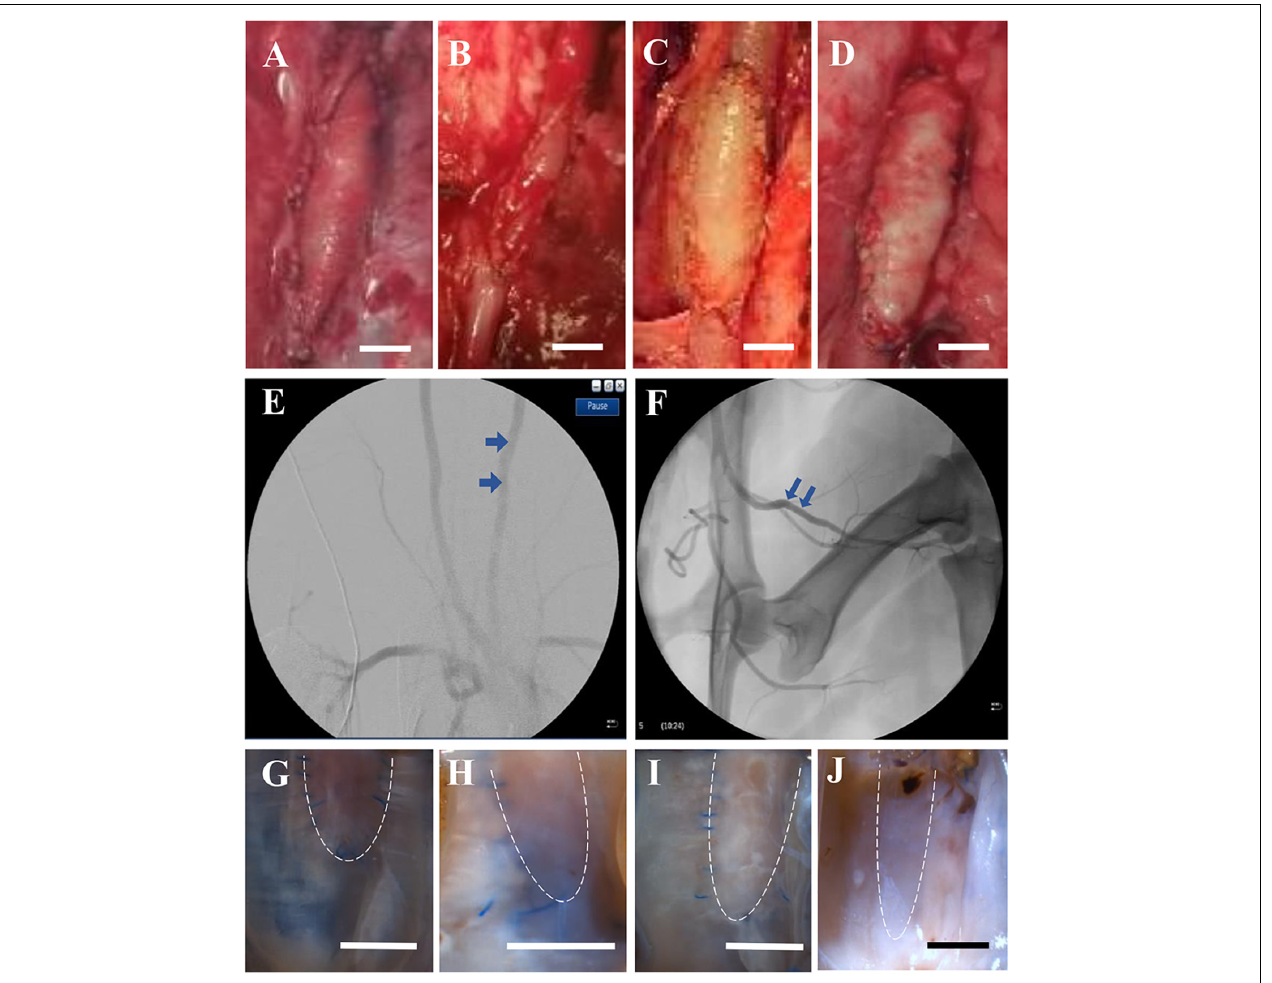
FIGURE 1 | Typical gross and angiograph images of patch-angioplasties. (A) The sPVP in the carotid artery in 4-M Group. (B) The sPVP in the femoral artery in 4-M Group. (C) The bPVP in the carotid artery in HF/4-M Group. (D) The bovine pericardium in the carotid artery in HF/4-M Group. (E) The angiographic image of the bPVP in the carotid artery in HF/4-M Group. (F) The angiographic image of the sPVP in the femoral artery in 4-M Group. (G) The luminal surface of the sPVP in the carotid artery in 4-M Group. (H) The luminal surface of the sPVP in the femoral artery in 4-M Group. (I) The luminal surface of the bPVP in the carotid artery in HF/4-M Group. (J) The luminal surface of the bPcdm in the carotid artery in HF/4-M Group. The bars on (A–D,G–J) are the scale of 5 mm. The dash lines on (G–J) indicate the fractional patch-angioplasties (other tissues were processed for histology/immunofluorescence).